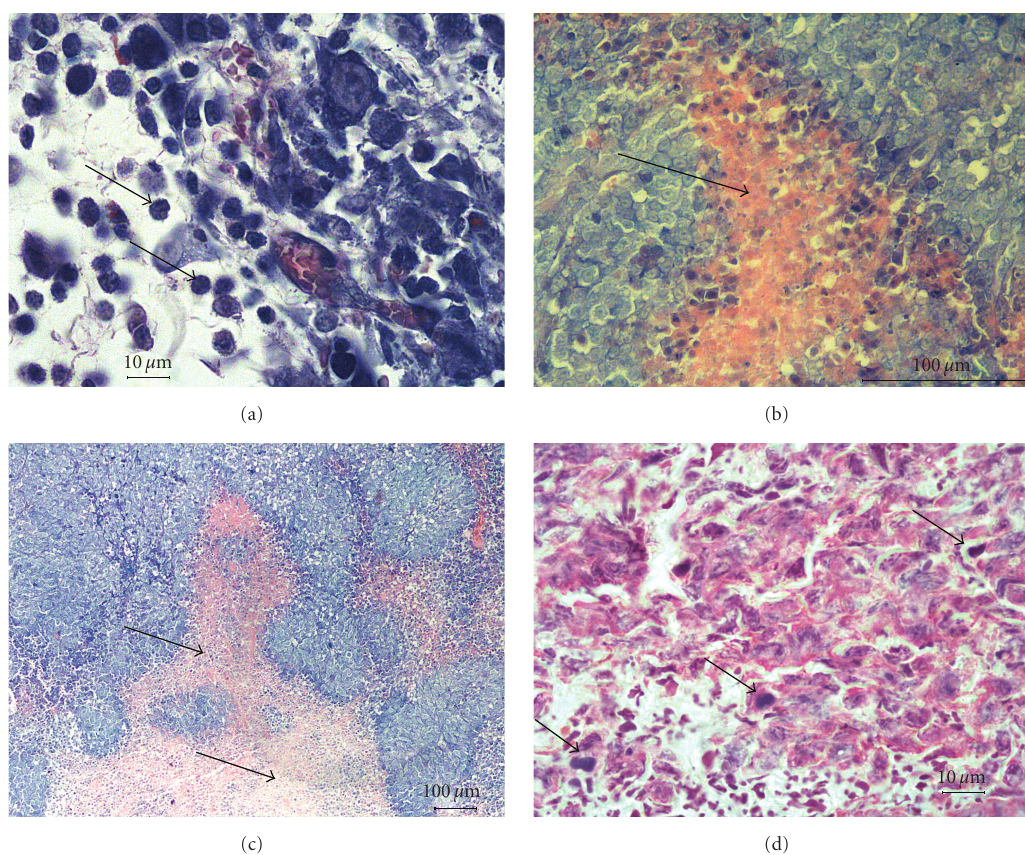
Figure 6: Microphotographs of hepatoma 22a. (a) Tumor at 7 day after tumor inoculation × 900. Mononuclear infiltration at the periphery of tumor nodule is shown by arrows. Azure-II-eosin staining. (b) Tumor at 14 day after inoculation × 600. The appearance of first central necrosis is shown by arrow. Azure-II-eosin staining. (c) Tumor at 21 day after inoculation × 200. Necrotic tissue (shown by arrows). Azure- II-eosin staining. (d) Tumor at 28 day after inoculation × 900; Mitosis in the remaining viable tumor tissue. Hematoxylin-eosin staining.